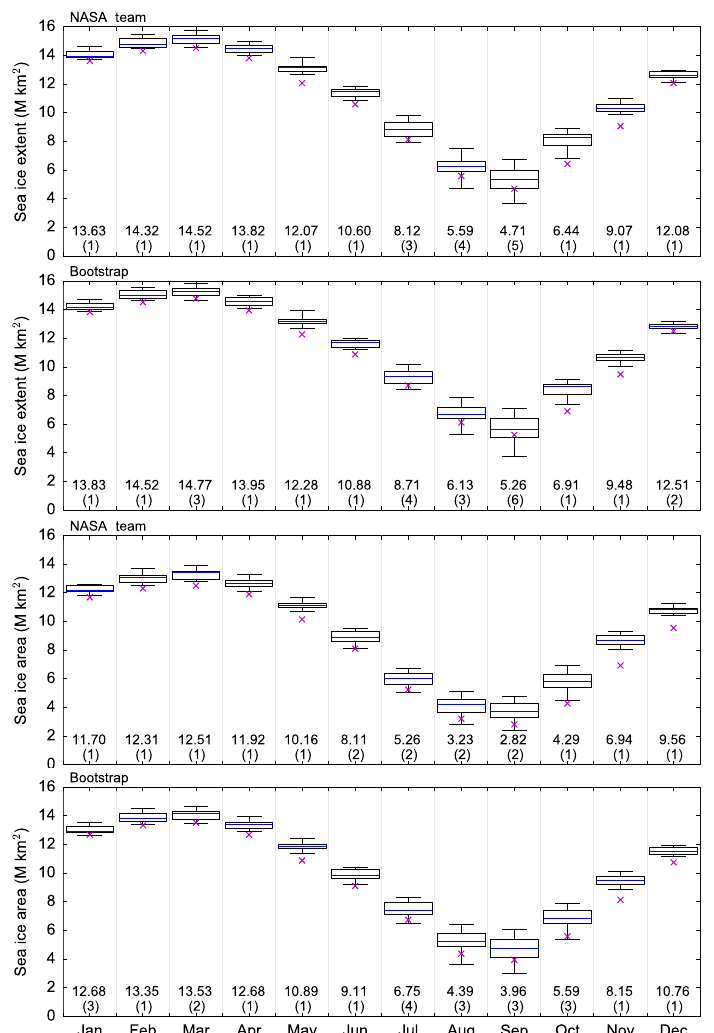
Figure 3. Box-and-whisker plots for the period 2000–2015 of observed monthly sea ice extent (SIE, a, b ) and sea ice area (SIA, c, d ) calculated using the NASA Team (a, c) and Bootstrap (b, d) sea ice concentration data. The magenta crosses and the number above the brackets (in million km 2 ) denote the monthly 2016 SIE or SIA, while the number in brackets gives the rank of the 2016 SIE or SIA across the 2000–2016 period (1 represents a record low in